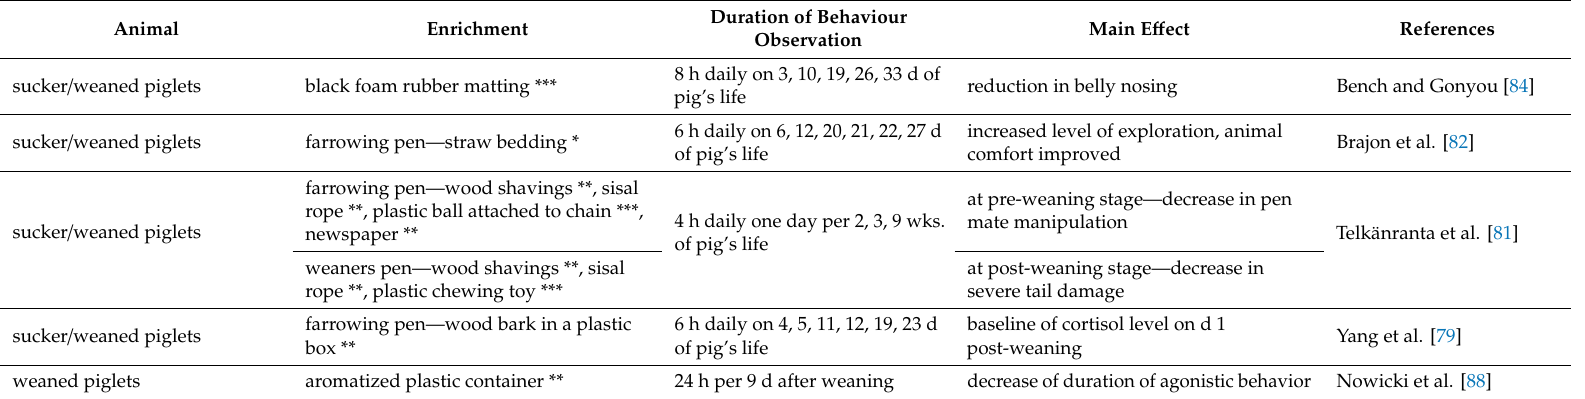
Table 1. Environmental enrichment materials and objects according to the categories included in the Commission Recommendation (EU) 2016 / 336, and their main e ff ects on sucker and weaned piglets’